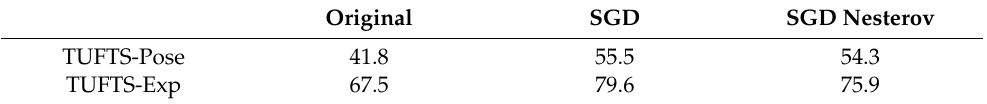
Table 6. Rank-1 results (in %) achieved by different models for extraction of LWIR band features. Original SGD SGD Nesterov TUFTS-Pose